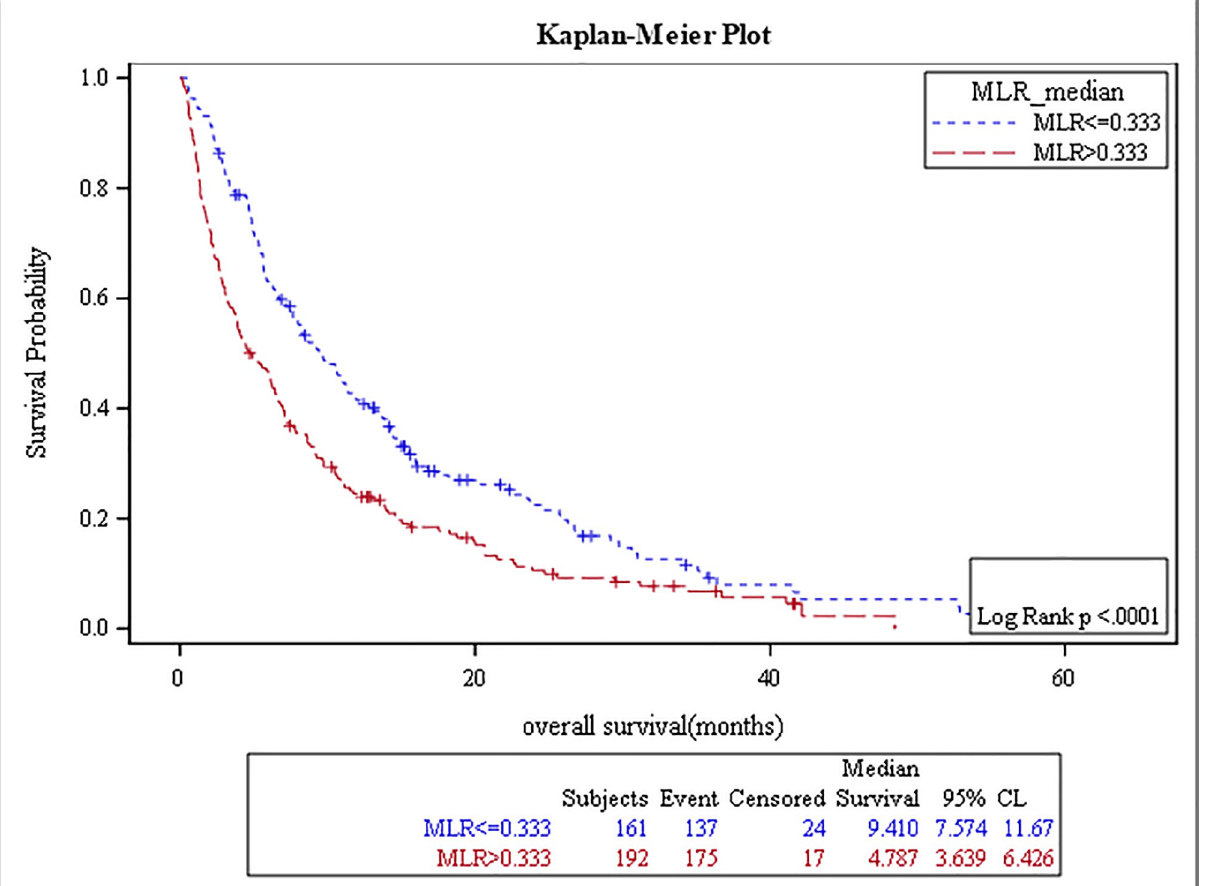
Fig 4. Kaplan Meier curve for overall survival for patients with MLR �